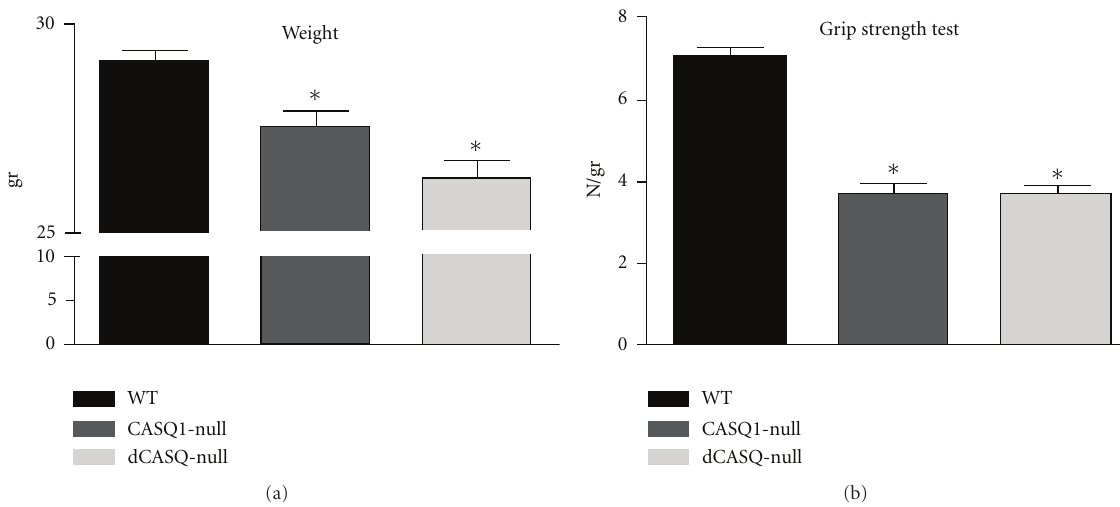
Figure 3: Ablation of CASQ1 and of both CASQ isoforms resulted in a significant reduction in body weight and grip strength test. (a) Ablation of CASQ1 and/or of both CASQ isoforms resulted in a significant reduction of body weight, which was more pronounced in dCASQ-null than in CASQ1-null mice ( n = 86, 65, and 33 animals for WT, CASQ1-null, and dCASQ-null, resp.). (b) The evaluation of the maximal force that mice produced while grasping a bar (grip strength test, [33]) showed that the force output of CASQ1-null and dCASQ-null mice was significantly lower than that of WT animals, but not di ff erent from each other ( n = 26, 39, and 33 animals for WT, CASQ1-null, and dCASQ-null, resp.). Both body weight and grip strength test were measured in male mice. ∗ Significantly di ff erent from WT.